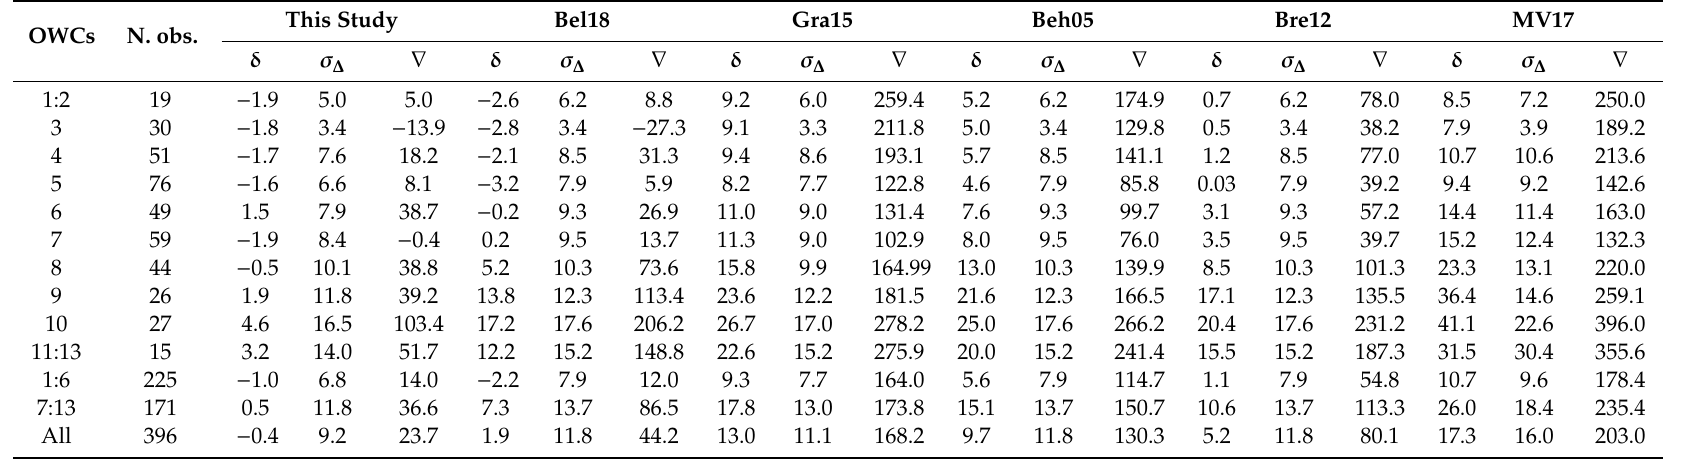
Table 1. Basic statistics for each single approach. For each approach is reported the bias ( δ ; in mg m − 3 ), the standard deviation ( σ ∆ ; in mg m − 3 ), and the relative percentage bias ( ∇ ; in %). Note that OWCs 1 and 2 are grouped in a single class to increase the number of observations available for the statistics. This is also replicated for OWCs 11, 12, and 13. The statistics using log 10 transformed data for all OWCs are reported in Table S1. OWCs N.